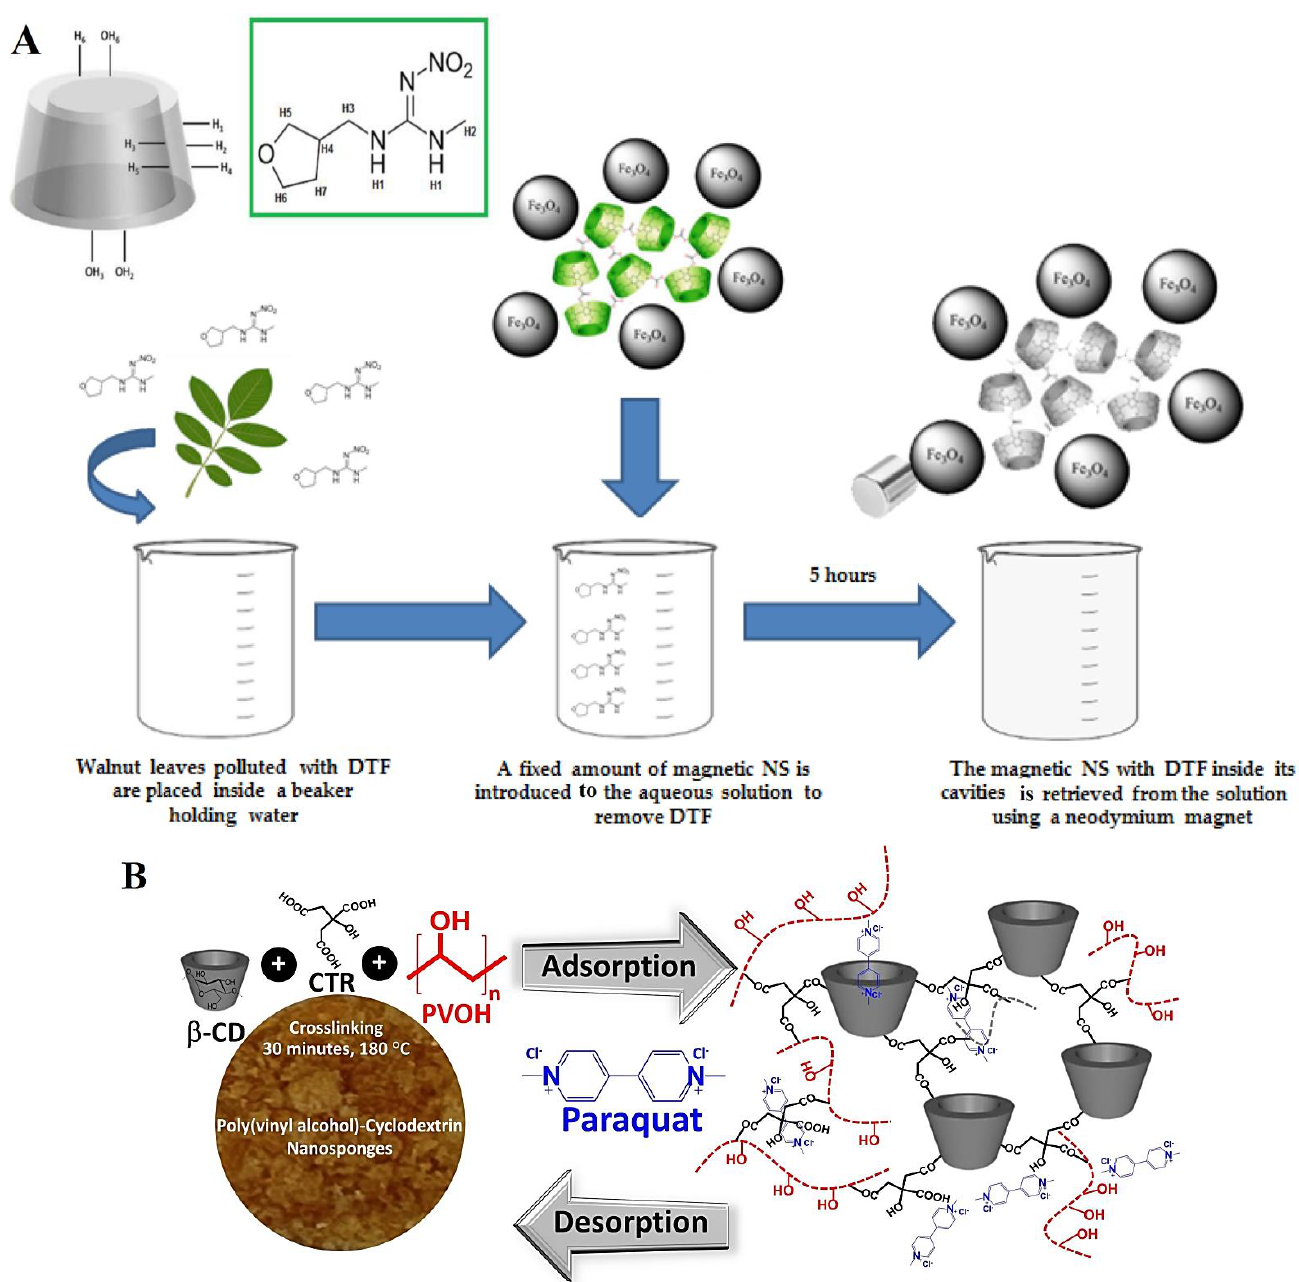
Figure 3. ( A ) β -cyclodextrin-based nanosponges (NS) are functionalized by magnetic nanoparticles for the removal of dinotefuran (DTF) pollutant. Adapted with permission from Ref. [51]. Copyright 2020, Multidisciplinary Digital Publishing Institute (CC BY 4.0). ( B ) Poly(vinyl alcohol)-cyclodextrin nanosponges for the adsorption of paraquat (a hazardous agrochemical) from water. CTR: citric acid; β -CD: β -cyclodextrin. Adapted with permission from Ref. [52]. Copyright 2021, Multidiscipli- nary Digital Publishing Institute (CC BY